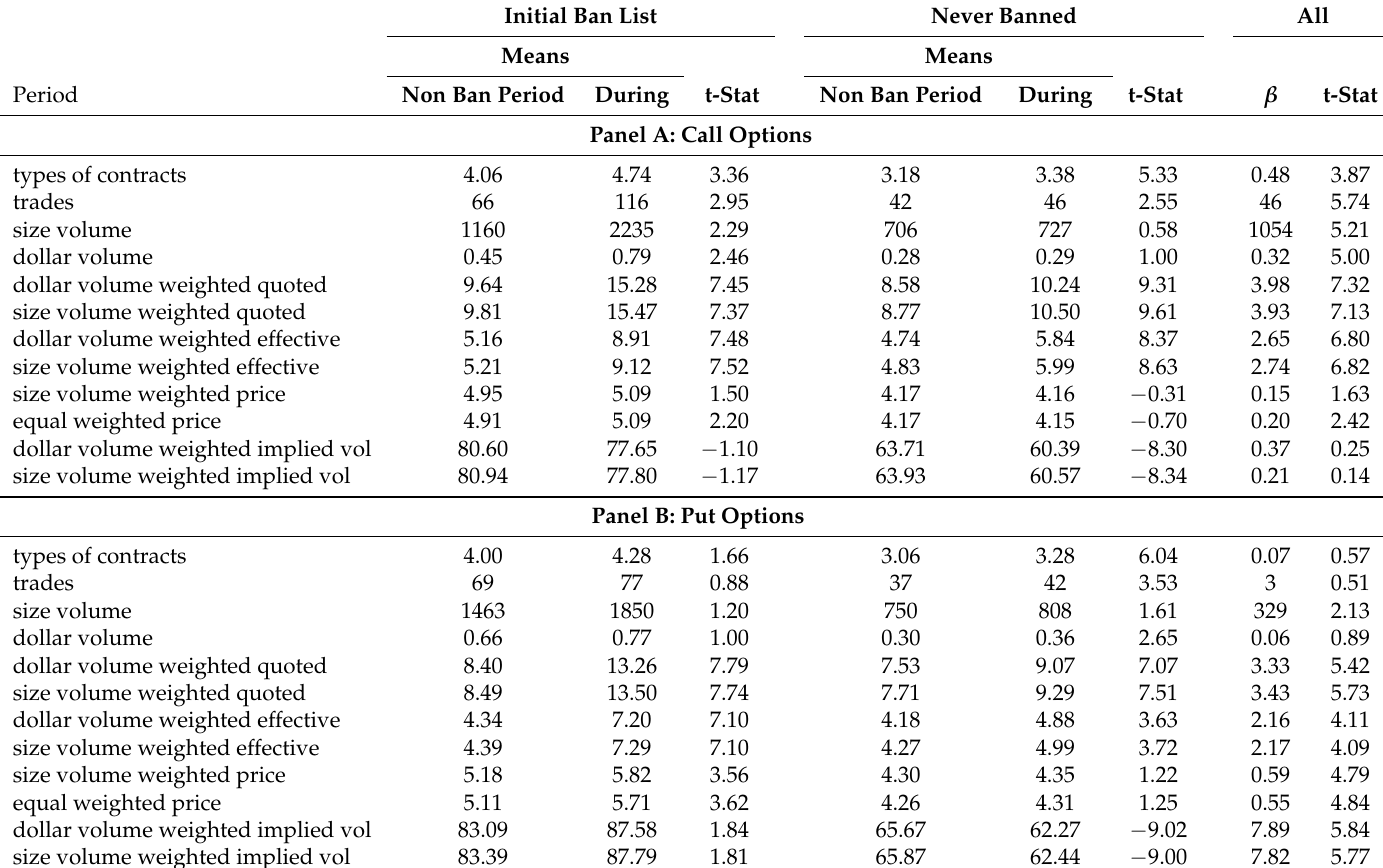
Table 3. Cross sectional means and t-statistics for option trade summary statistics: At the money